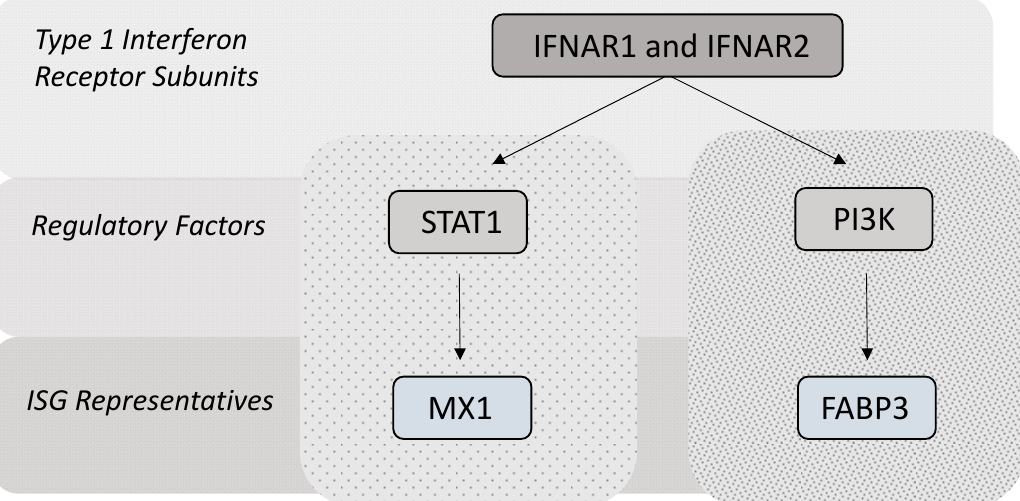
Figure 1. Schematic illustration of selected target gene representatives. Type 1 interferon receptor subunit 1 (IFNAR1); Type 1 interferon receptor subunit 2 (IFNAR2); signal transducer and activator of transcription 1 (STAT1); phosphoinositide 3-kinase (PI3K); interferon-stimulated gene (ISG); interferon-induced GTP-binding protein (MX1); fatty acid-binding protein 3 (FABP3).